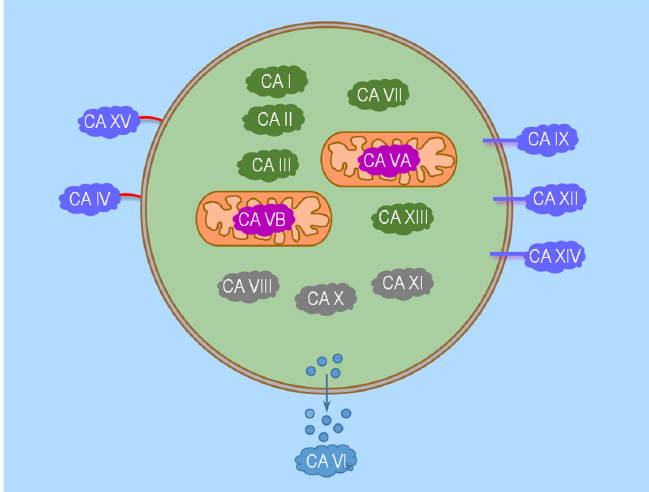
Figure 1. Cartoon illustrating the sub-cellular localization of the currently known α -CA family members. According to their sub-cellular localization, α -CAs can be classified into four groups: cytosolic (CA I, CA II, CA III, CA VII, CA VIII, CA X, CA XI, and CA XIII), mitochondrial (CA VA and CA VB), secretory (CA VI), and membrane-associated (CA IV, CA IX, CA XII, CA XIV, and CA XV). The cytosolic isozymes are all active (indicated in dark green) except for CA VIII, X, and XI (in grey), which are also called CA-related proteins (CARPs). Of the membrane-associated CAs, CA IV and CA XV are glycosylphosphatidylinositol (GPI)-linked, whereas CA IX, CA XII, and CA XIV are transmembrane. Note that the mitochondrial CA VA and CA VB are encoded by two different genes